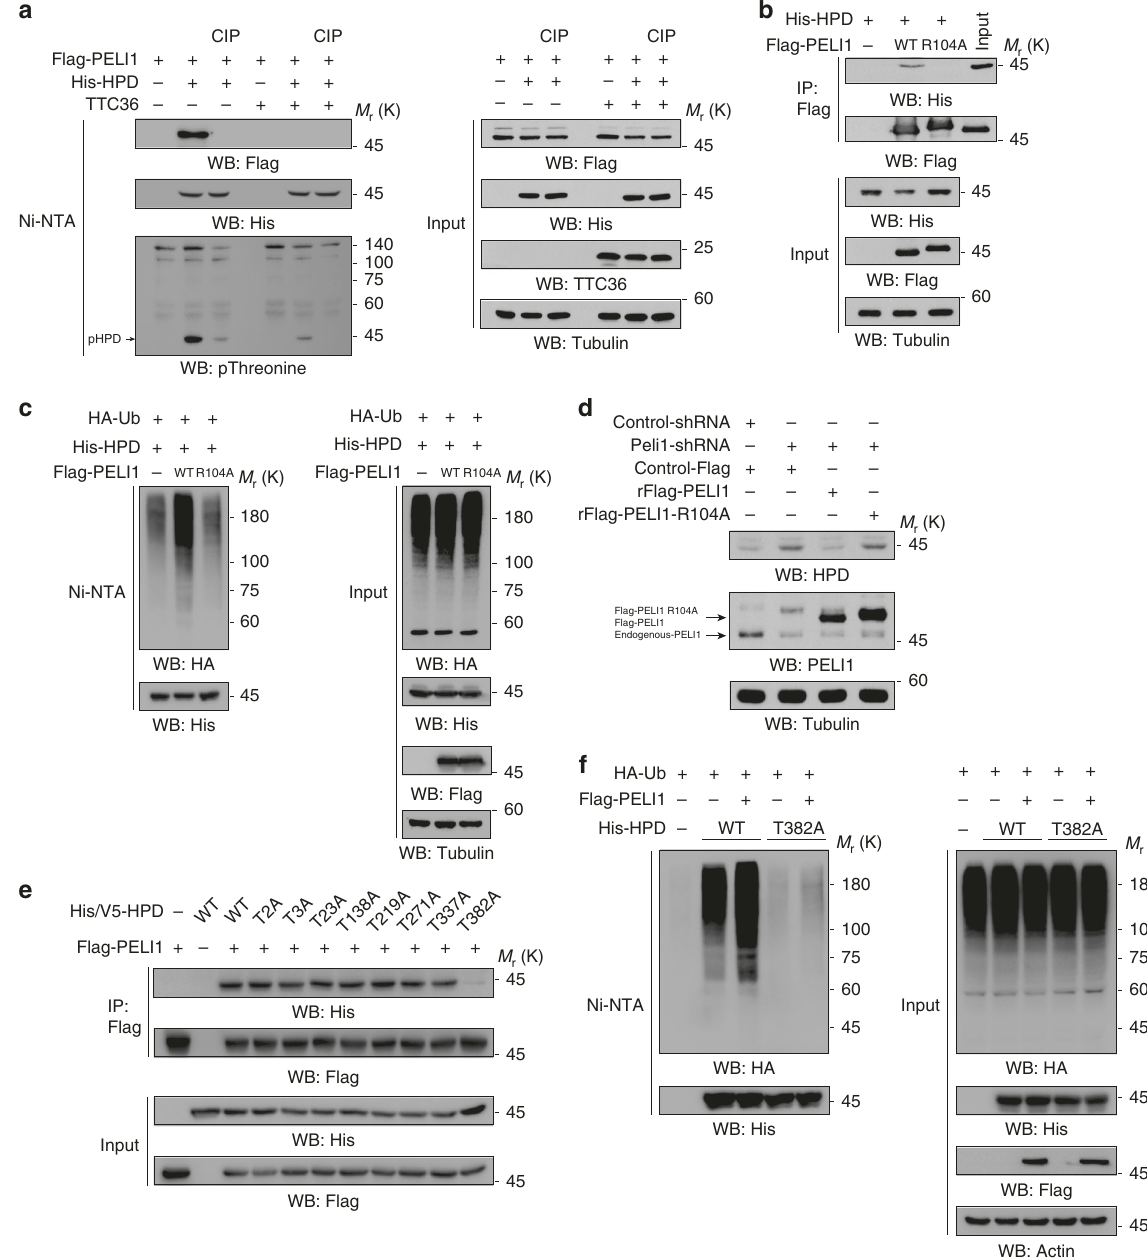
Fig. 3 PELI1 binds to phosphorylated T382 of HPD. Immunoblotting analyses were performed with the indicated antibodies a – f . a HEK293T cells were transfected with the indicated plasmids. MG-132 (10 μ M) was added into the culture medium of the cells 12 h before they were harvested. The cell lysates were treated with or without calf intestinal alkaline phosphatase (CIP) (1 unit CIP per µ g of protein). A Ni-NTA pull-down assay was performed. b HEK293T cells were transfected with indicated plasmids. Immunoprecipitation with an anti-Flag antibody was performed. c WT Flag-PELI1 or Flag-PELI1 R104A was expressed in HEK293T cells expressing HA-Ub and His-HPD. MG-132 (10 μ M) was added to the cells 12 h before they were harvested with a guanidine – HCl-containing buffer. A Ni-NTA pull-down assay was performed. d LO2 cells expressing Peli1 shRNA were reconstituted with expression of RNAi-resistant WT PELI1 or PELI1 R104A. e HEK293T cells were transfected with indicated plasmids. Immunoprecipitation with anti-Flag antibody was performed. f His-HPD WT or His-HPD T382A were expressed in HEK293T cells expressing HA-Ub, with or without reconstituted expression of Flag-PELI1. MG-132 (10 μ M) was added to the cells 12 h before they were harvested with a guanidine – HCl-containing buffer. A Ni-NTA pull-down assay was performed (Fig. 5a). In addition, Ttc36 − / − mouse primary hepatocytes had by inhibiting STK33-mediated HPD phosphorylation and PELI1- enhanced binding of HPD to STK33 and PELI1 (Fig. 5b). ML281 dependent HPD degradation in mouse hepatocytes. treatment abrogated TTC36 de fi ciency-enhanced HPD Thr382 HPD de fi ciency has been linked to tyrosinemia and neurolo- phosphorylation and HPD degradation (Fig. 5c). Collectively, gical disorders in human patients 9,10 . HPD de fi ciency in mice did not affect body weight (Supplementary Fig. 4a) nor the levels of these results strongly suggest that TTC36 increases HPD stability